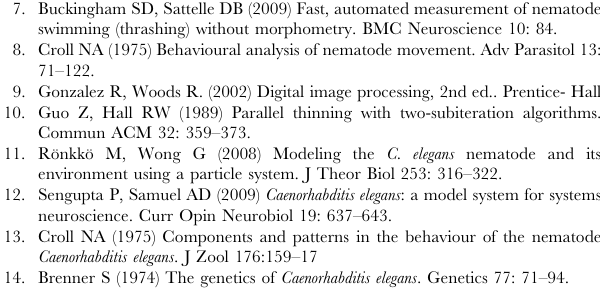
Figure S1 Stereomatching process for kinematic anal- ysis. (A) Two skeletons of a worm overlapped on raw images. (B)